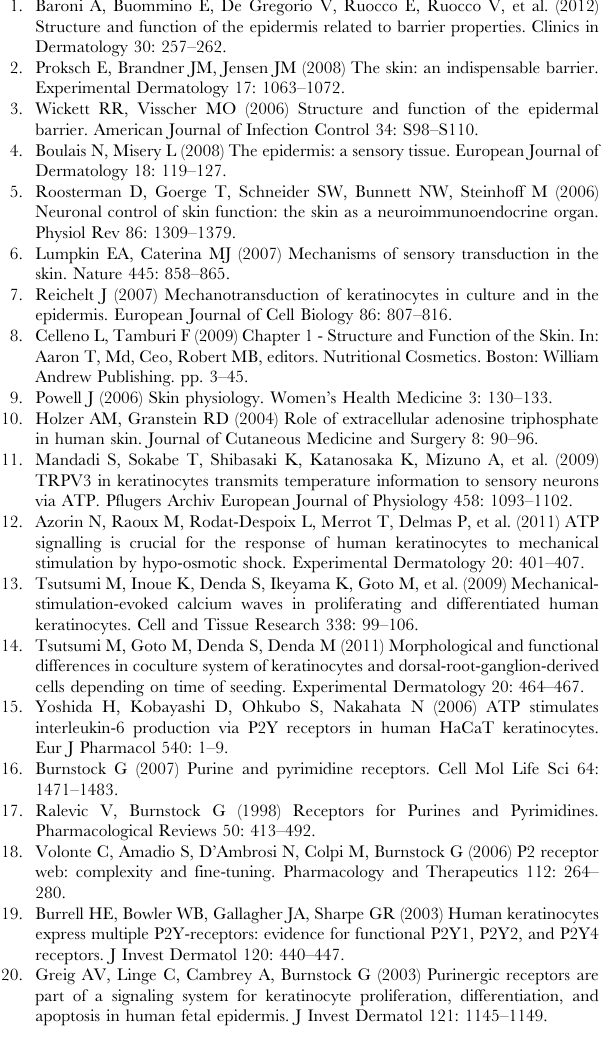
Figure S6 Extracellular hexokinase suppresses the ADP-induced [Ca 2 + ] i increase. Bars denote the nucleotide- induced peak [Ca 2 + ] i increase with or without extracellular hexokinase that was added right before the assay. Numbers on the gray bar denote the amount of hexokinase in a 150 m l reaction volume (mean 6 SEM, n = 3, RFU: relative fluorescence unit defined as D F/F 0 , two-way ANOVA followed by Bonferroni’s multiple comparison test, ** p , 0.01; *** p , 0.001; ns= not significant).